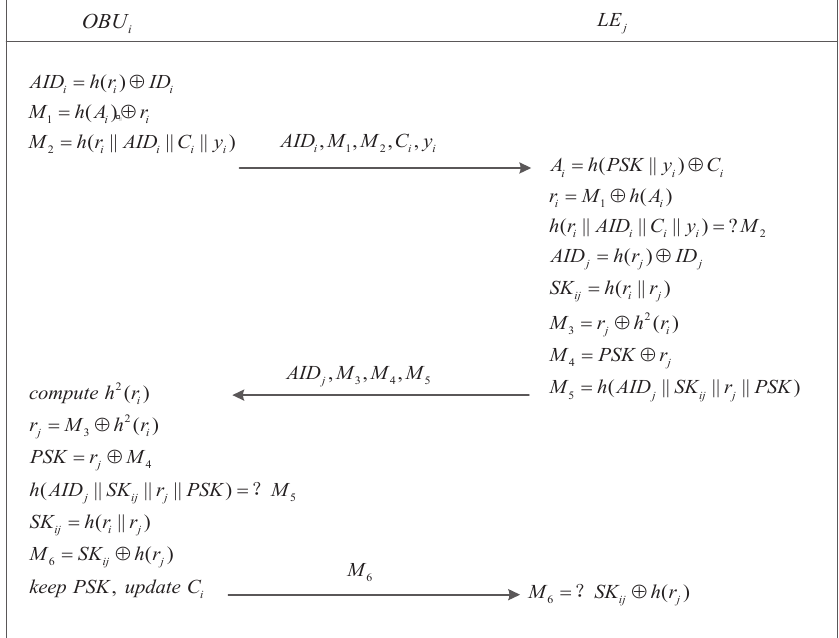
Figure 4. General authentication